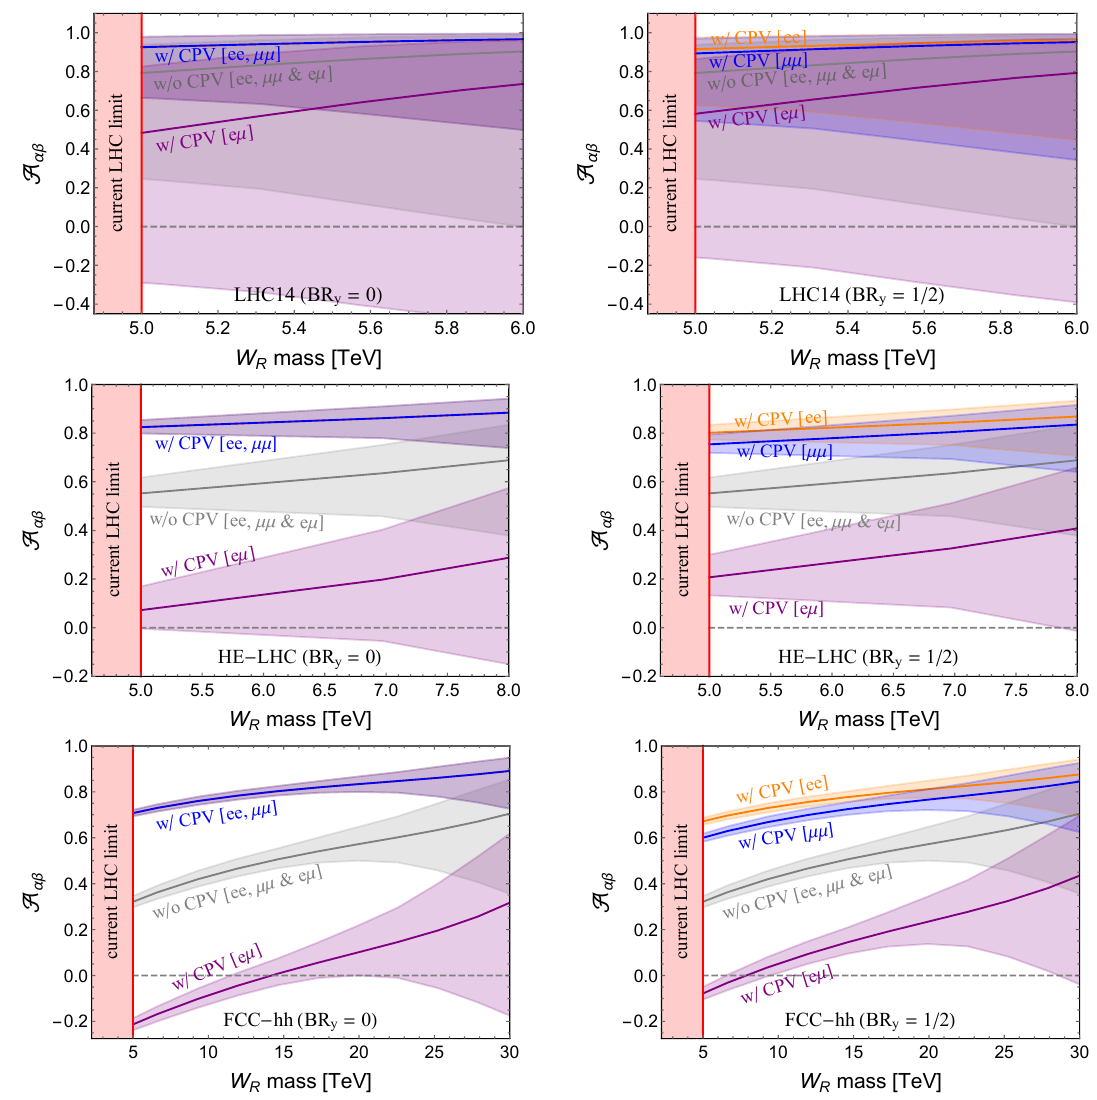
Figure 2. Prospects of at the 14 TeV LHC (upper), 27 TeV HE-LHC (middle) and 100 TeV A (cid:11)(cid:12) FCC-hh (lower), as functions of W R mass, with BR y = 0 (left panels) and BR y = 1 = 2 (right panels). The solid gray line in each plot corresponds to the values of without CPV in the RHN A ee;(cid:22)(cid:22);e(cid:22) sector, and the solid orange, blue and purple lines are respectively for , A (cid:22)(cid:22) and with A ee A e(cid:22) (cid:18) R = (cid:25)= 4 and (cid:14) R = (cid:25)= 4 (in the three left panels the ee and (cid:22)(cid:22) bands overlap with each other). The shaded bands are due to the PDF uncertainties, and the vertical (red) shaded region is excluded by the current LHC searches of W R boson with g R = g L [23, 24, 57]. The horizontal dashed gray lines indicate = A (cid:11)(cid:12)